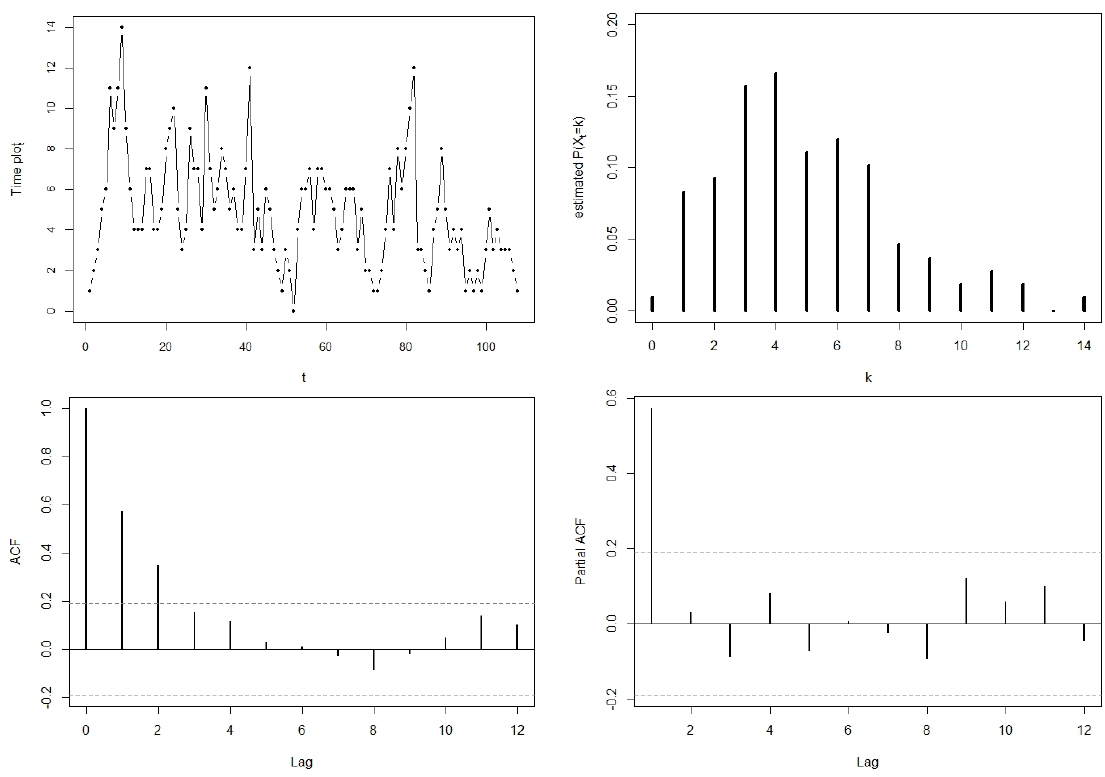
Figure 6. The time plot, observed marginal distribution, ACF, and PACF of the strikes